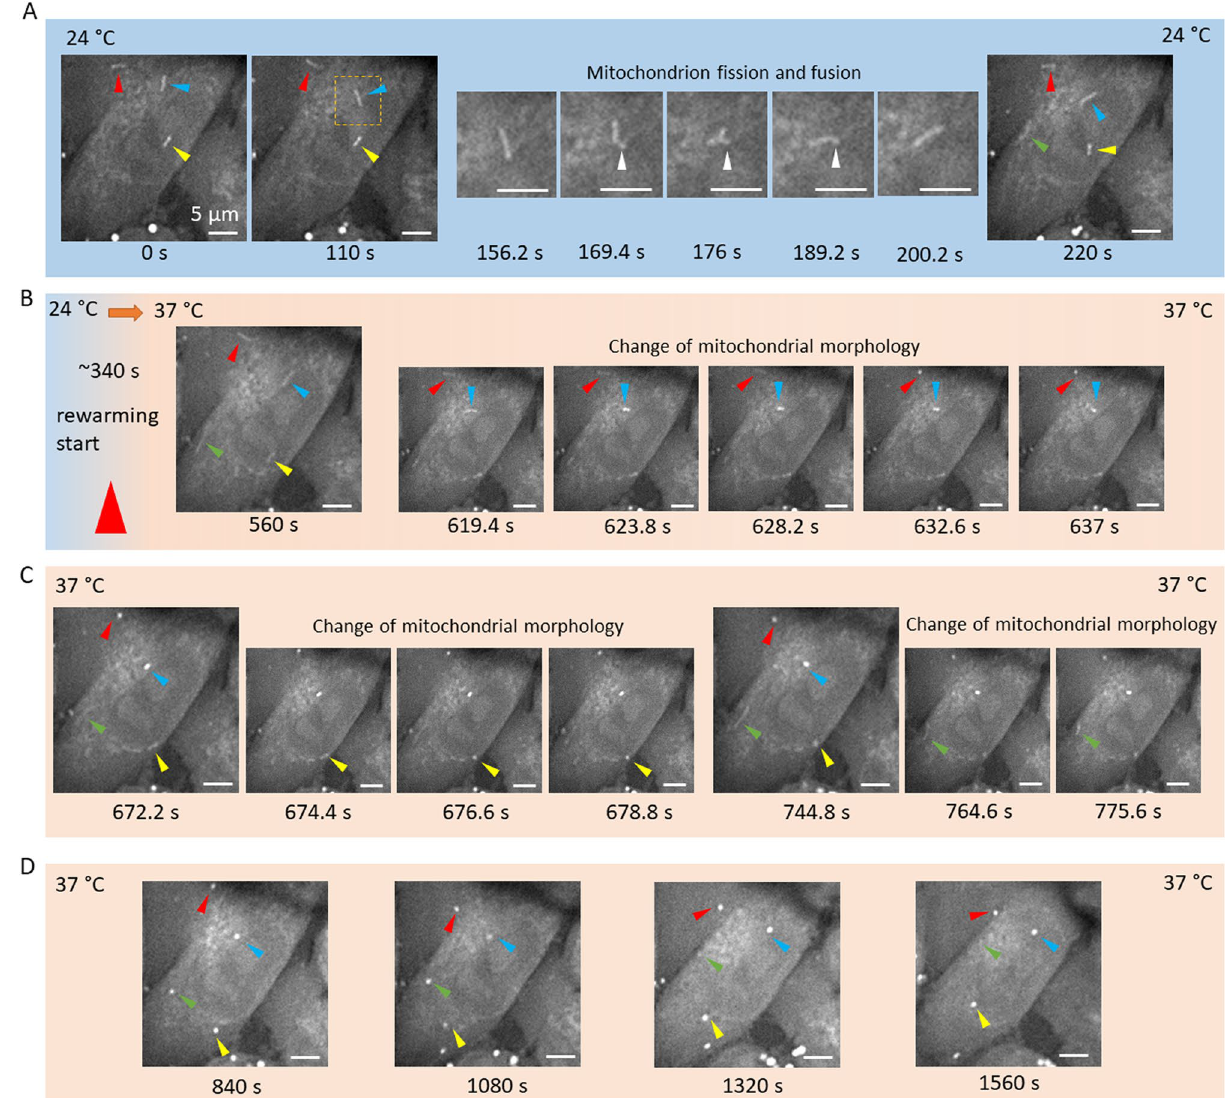
Figure 4. Time-lapse CARS images of a MIAPaCa-2 cell rewarming from hypothermia exposure at 24 °C to physiological temperature at 37 °C. ( A ) Imaging of the cell began in the hypothermia environment (24 °C). Rod-like FA-accumulated mitochondria were observed (colored arrows). Mitochondria fission and fusion were also observed from 156.2 s to 200.2 s (white arrows). ( B ) Rewarming started at ~ 340 s. Two FA-accumulated mitochondria were observed to change their structures. ( C ) Two additional FA-accumulated mitochondria were observed to change their structures. ( D ) All four FA-accumulated mitochondria exhibited dot-like morphology. Scale bars represent 5 µm and apply to all images in the